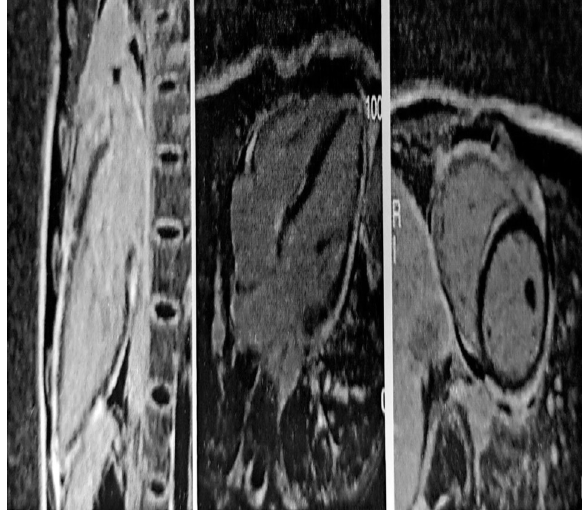
Figure 3. Cardiac MRI: late gadolinium enhancement imaging shows sub-epicardial hyperenhancement from the basal to apical lateral wall and basal to apical inferior wall that extends to mid anterior wall. There is also mid-wall fibrosis at mid septal region.